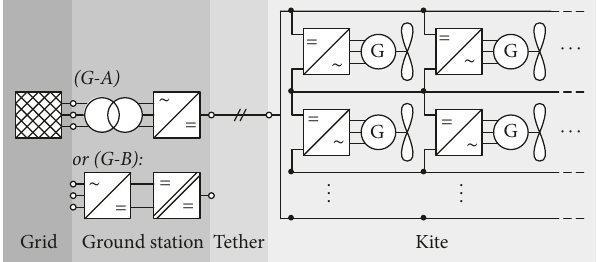
Figure 4: Power electronic topology with DC transmission and partly DC-series connected drives, proposed by the authors [11] and independently patented by Makani [12]. The power converters on ground may be identical to Figure 2.